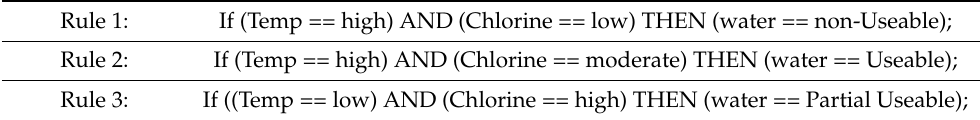
Table 1. Sample rule for predicting the water quality.